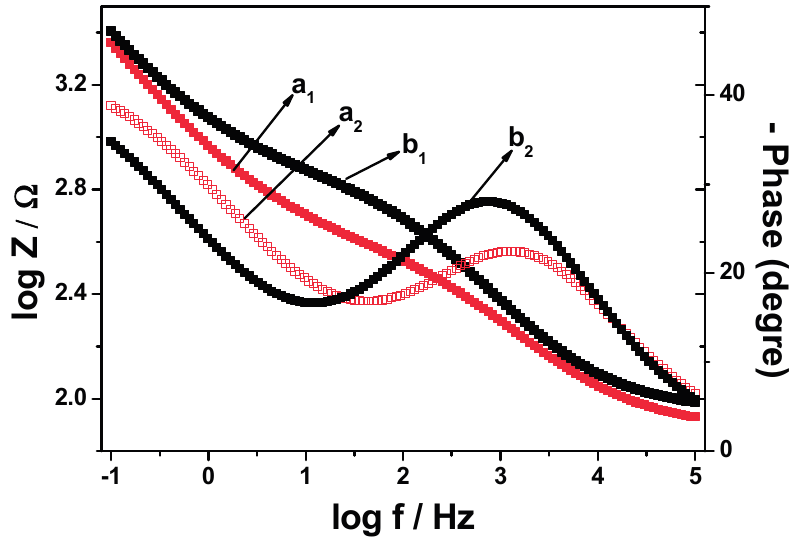
Figure 9. Bode plots of GCE/PT-PDMA-MWCNT after antibody immobilisation (curves a 1 and a 2 ) and after immobilisation and blocking with BSA (curves b 1 and b 2 ) in solution of 3 × 10 − 5 μ M of FB 1